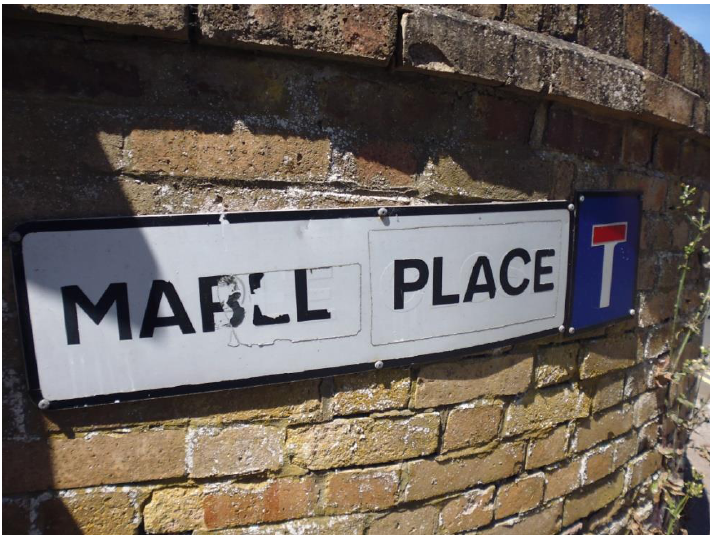
Figure 10. Street